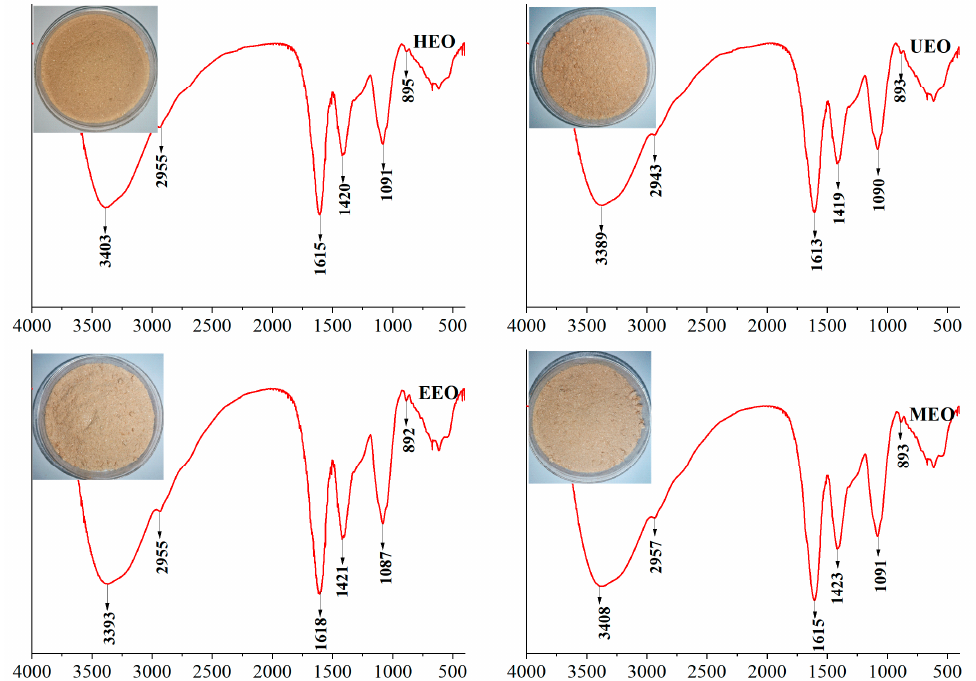
Figure 4. FT-IR (Fourier Transform Infrared Spectrometer) chromatograms of EOs.